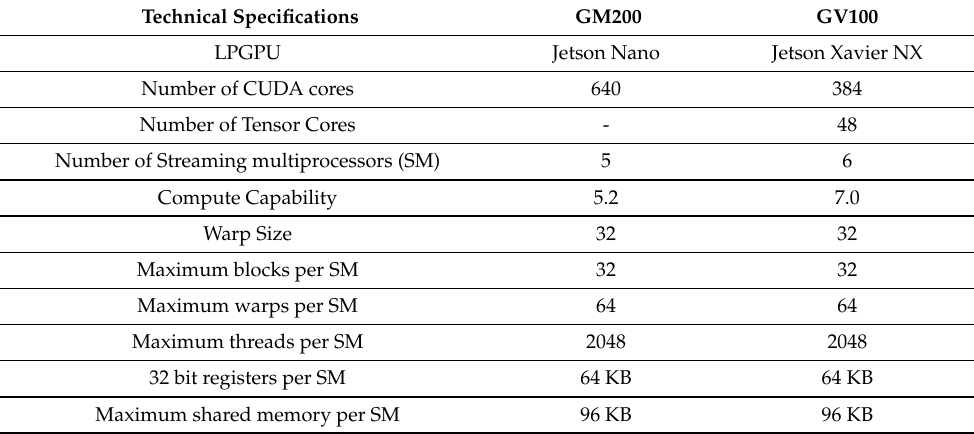
Table 3. Technical specifications of the LPGPU in NVIDIA Jetson Nano and NVIDIA Jetson Xavier